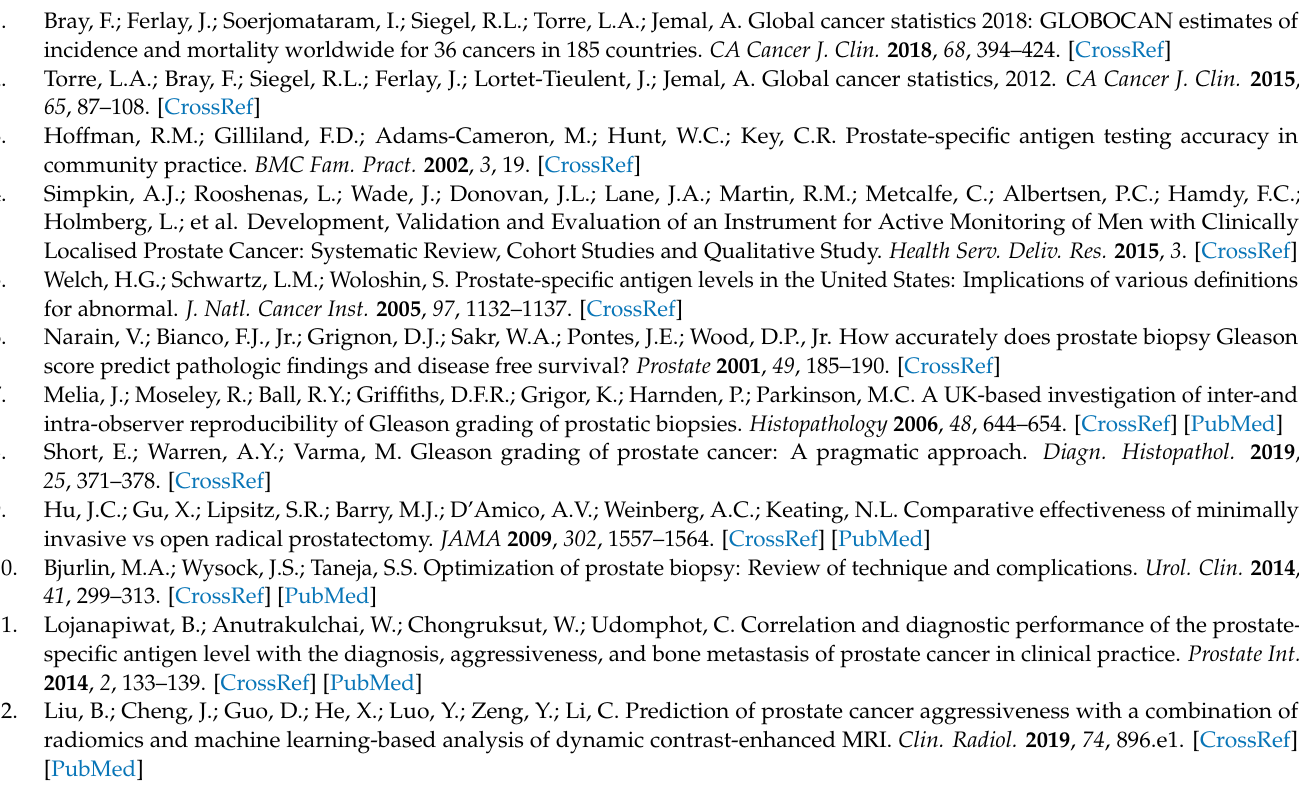
Table S2: Patients characteristics (n = 200). Table S3: GLCM T2WI texture features showing the Standard deviation, mean, number, median, minimum, and max-imum. Table S4: GLCM ADC texture features showing the Standard deviation, mean, number, median, minimum and maxi-mum. Table S5: Description of Gray-level co-occurrence Metrix (GLCM) features computed within the region of interest (ROI) of prostate